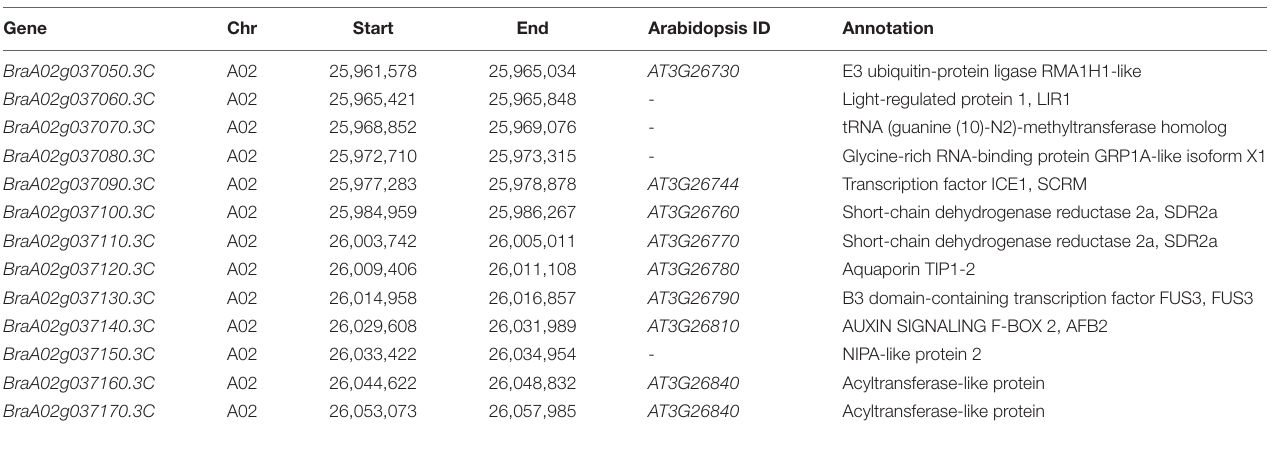
TABLE 3 | Thirteen annotated genes in the candidate region of BrPYP